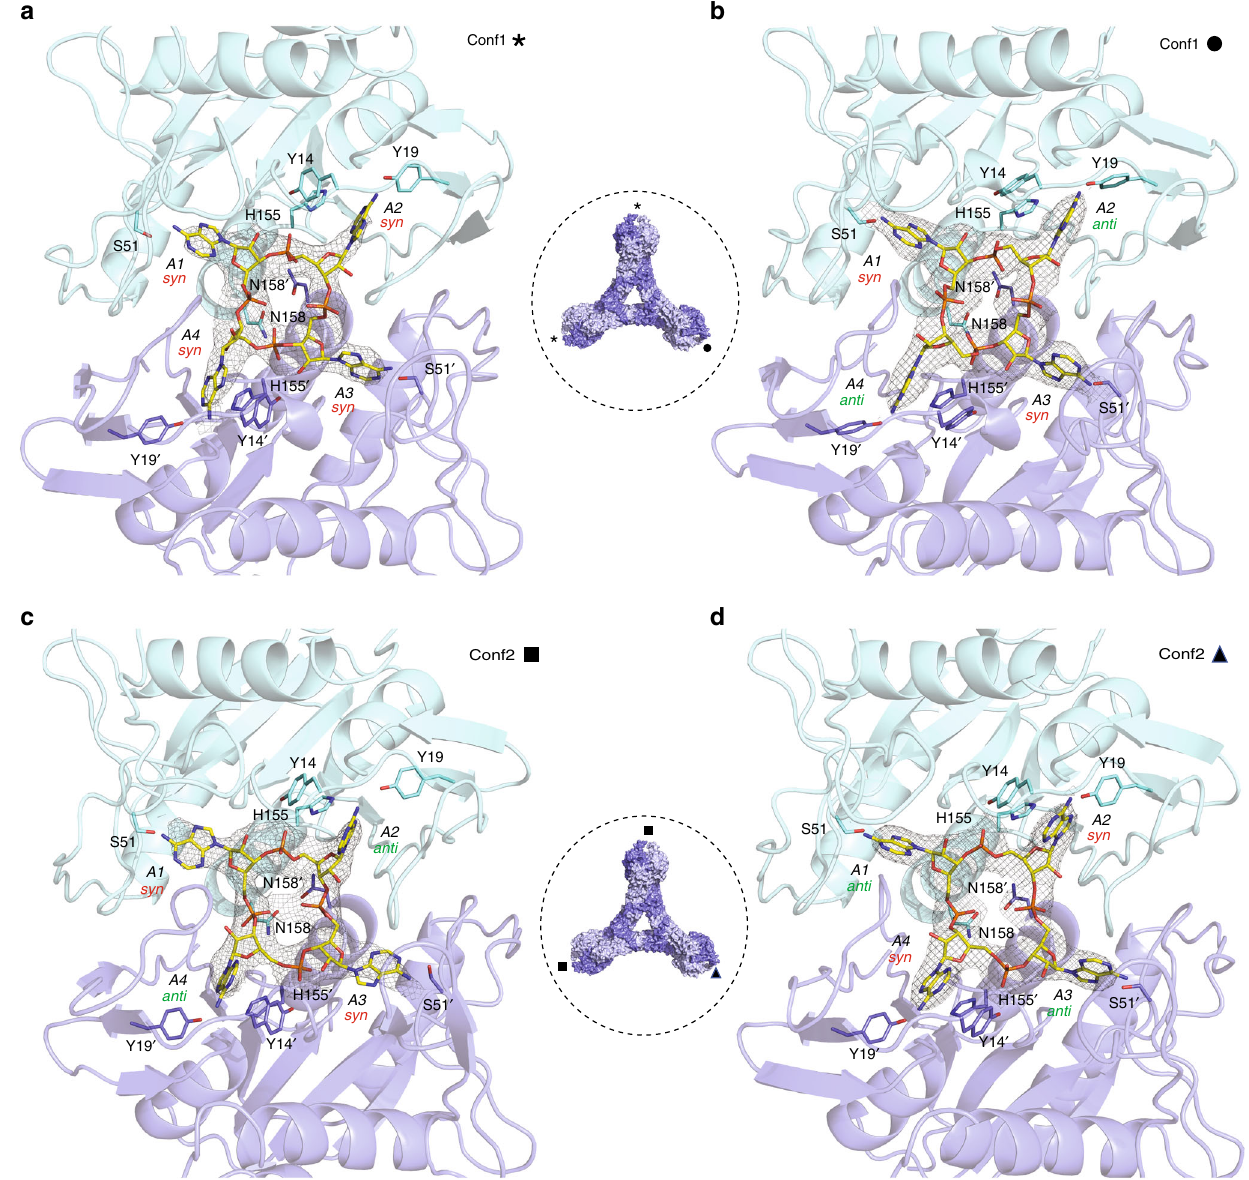
Fig. 3 cOA 4 con fi gurations in the binding pockets. a Detailed view of the cOA 4 binding site in conf1 including its interactions with key side chains. This con fi guration is observed in two of the binding pockets of the hexamer (indicated with an asterisk). b The third pocket in conf1 exhibits a different con fi guration of cOA 4 (indicated with a black circle). c Detailed view of cOA 4 binding site in conf2 including key side chain. This con fi guration is visualized in two of the binding pockets of the hexamer (indicated with a black square). d The conformation of cOA 4 is also different in the third binding pocket in conf2 (indicated with a black triangle). The 2mFo-DFc electron density maps in panels A-D are displayed at 1.1 σ contour. Views of the omit maps of a – d panels are provided in Supplementary Fig.